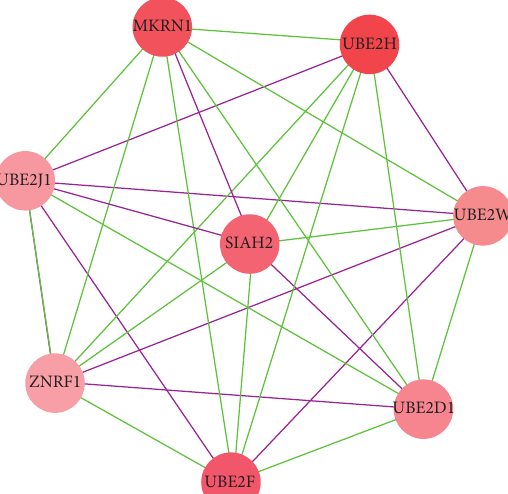
Figure 5: Hub genes extracted by MCODE plugin from the PPI network. MCODE, Molecular Complex Detection; PPI, protein-protein